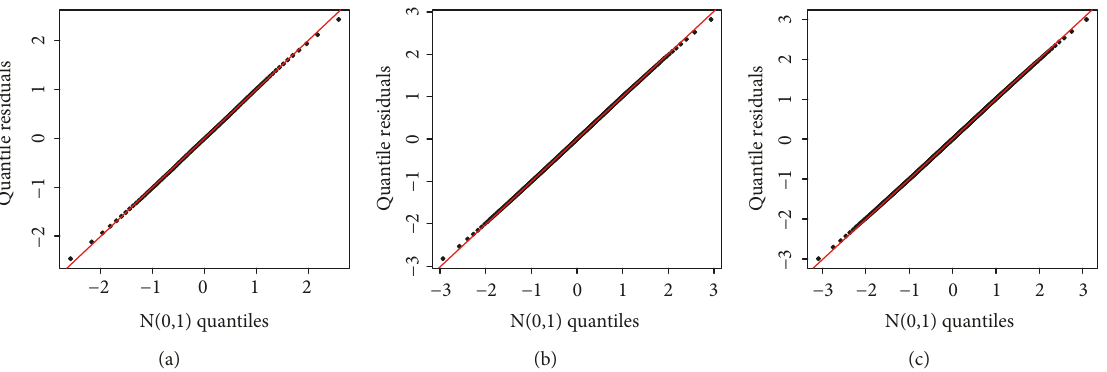
Figure 3: Normal probability plots for 𝑞𝑟 𝑖 in the OLLGIG regression model under scenario 1 ( 𝜏 = 0.5 ) (a) 𝑛 = 100 . (b) 𝑛 = 300 . (c) 𝑛 = 500 .